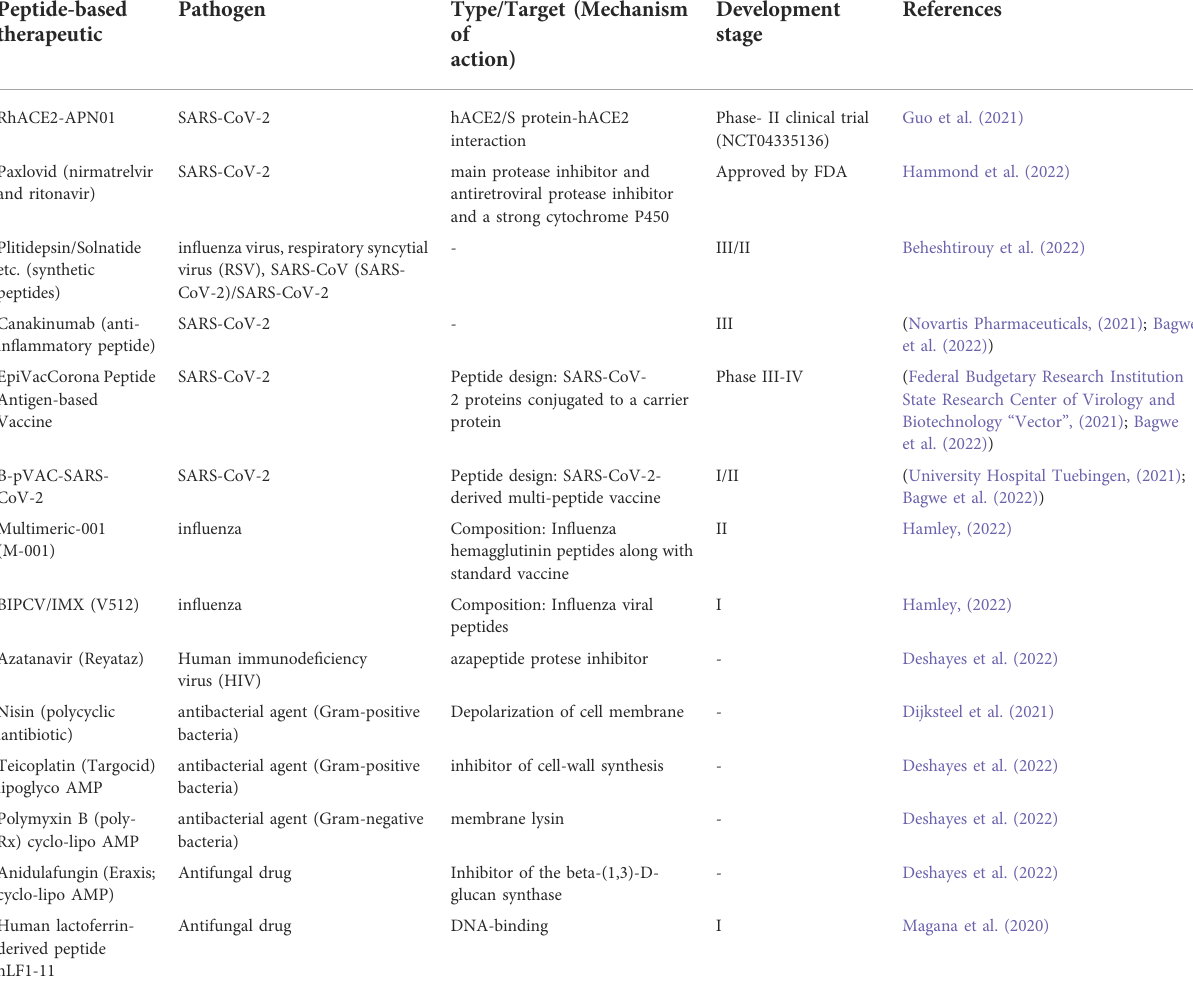
TABLE 1 Selected peptide-based therapeutics, in clinical use or under clinical studies, for infectious